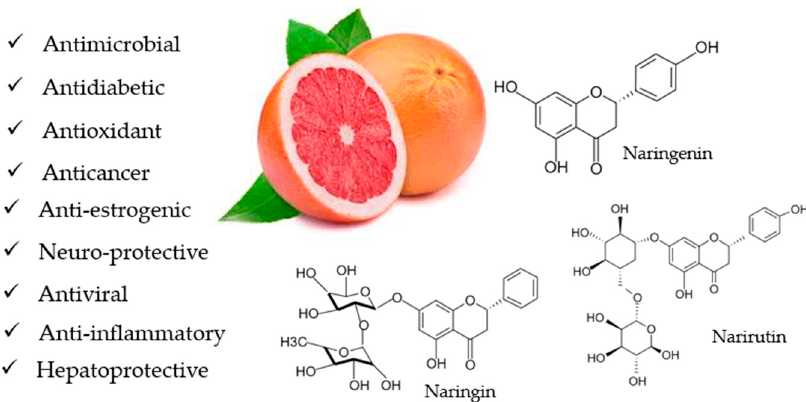
Figure 1. The effects of grapefruit ( Citrus x paradisi L.) and the main flavonoids found in its extracts. The anticancer, antiproliferative, and antitumor effects of naringenin are based on its DNA repair ability [13,14]. It has inhibited breast, liver, prostate, melanoma, and spinal cord glioblastoma cells. Naringenin also influences the intrinsic (mitochondrial) and ex- trinsic (receptor) apoptotic pathways. The effect of naringenin on apoptosis inhibits pro- liferation and angiogenesis